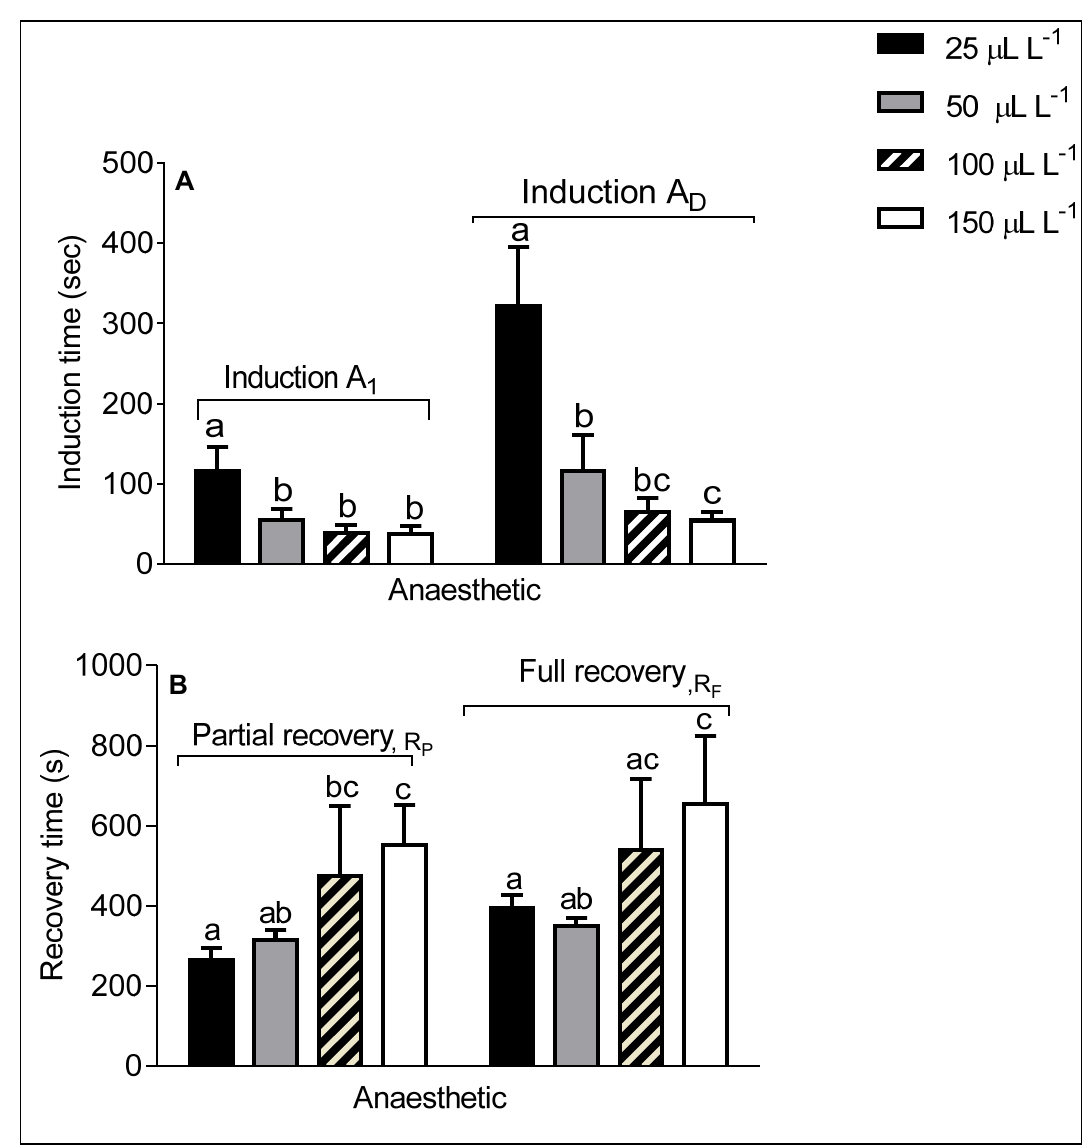
Figure 1. Induction (A 1 and A D ) ( A ) and recovery (R P and R F ) ( B ) time in Mozambique tilapia ( Oreochromis mossambicus ) subjected to different concentrations of oregano (OEO). Values are given as mean ± standard error ( N = 9), and different lowercase letters indicate significant differences between treatment groups. Values were subjected to one-way ANOVA and Tukey’s multiple comparison test to determine the significant differences between each anaesthetic stage and OEO concentrations at the p < 0.05 significance level.